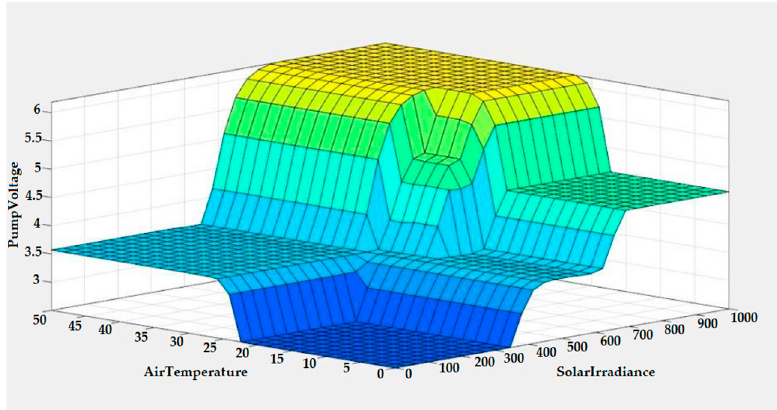
Figure 8. Surface graph of air temperature and solar irradiance vs. pump voltage.